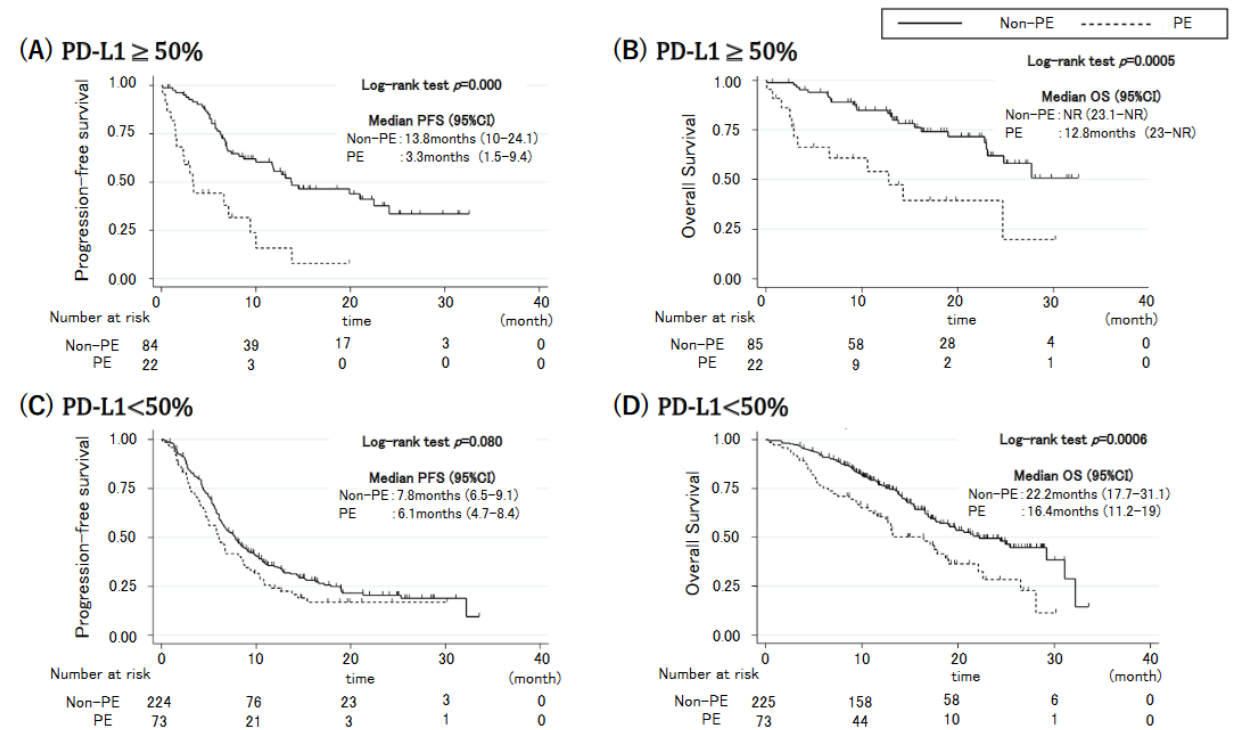
Figure 2. Kaplan-Meier curves for progression-free survival and overall survival in patients with ( A , B ) high ( ≥50% ) and ( C , D ) low (<50%) programmed cell death-ligand 1 (PD-L1) expression. ( A , B ) high ( ≥ 50%) and ( C , D ) low (<50%) programmed cell death-ligand 1 (PD-L1) expression.